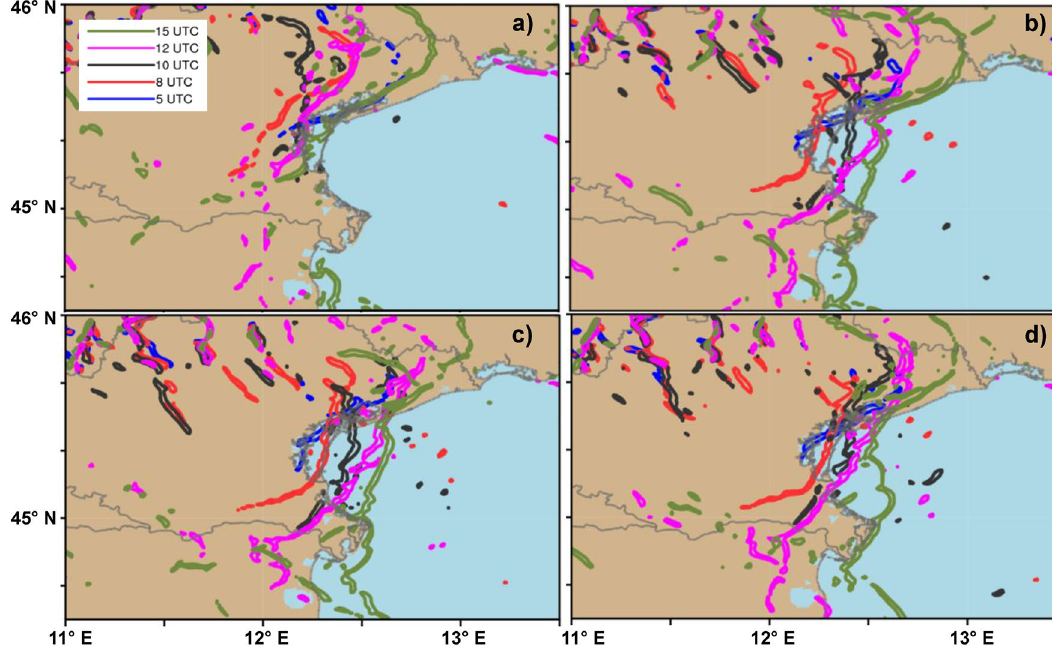
Figure 4. Convergence line (0.003 s −1 isoline) location at 05, 08, 10, 12, 15 UTC on September 26, for run RTG